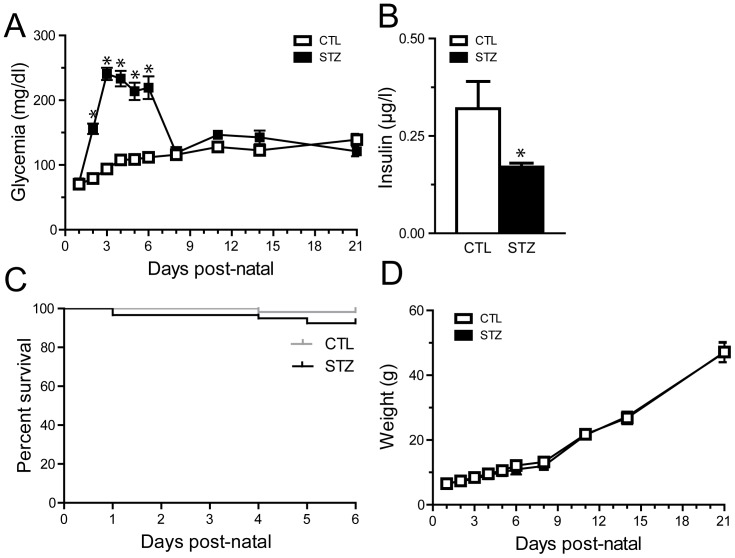
STZ leads to transient hyperglycemia without growth retardation in neonates.P1 rat pups were injected with low doses of streptozotocin in citrate buffer (STZ) or with the control vehicle (citrate buffer, CTL). A. Measurements of glycemia from P1 to P21 in both groups. The STZ group displayed a moderate increase in glycemia from P3 to P6, averaging 214 to 241 mg/dl (11.9–13.4 mmol/l). B. Insulin concentration in serum at P6 in control (white) and STZ treated (black) animals. The STZ group demonstrated a decreased level of insulin. C. Survival curve in STZ- and CTL-groups. Mortality was similar in both groups. D. Weight from P1 to P21 in STZ- and CTL-groups. Weight gain was not affected in STZ-injected animals when compared to control animals. Data in A and D were analyzed by a two-way ANOVA followed by a Bonferroni post test. Data in B were analyzed by an unpaired t-test. Data in C were analyzed by a Log-rank test. * P<0.05.